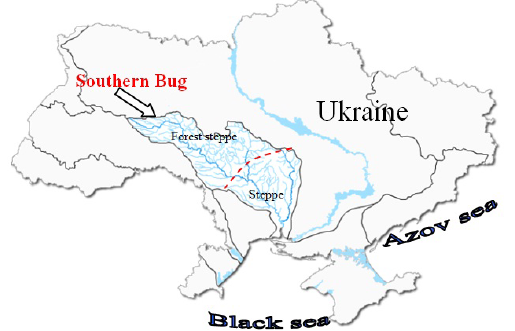
Figure 2. Location of the Southern Bug basin.